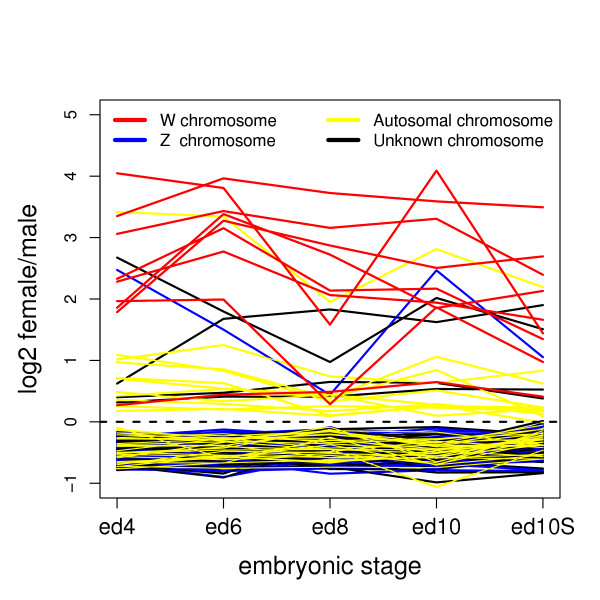
Expression difference between females and males of W-linked (red), Z-linked (blue), and autosomal (yellow) genes, and genes with unknown location (black), at ed4, 6, 8 and 10, respectively, for the 146 clones identified as significantly differentially expressed (adjusted p-value < 0.0005) in the microarray analysis. The log2 female/male ratios are averages between four replicate microarrays, using either the design illustrated in Figure 1A (ed4, ed6, ed8 and ed10), based on pools, or the design in Figure 1B (ed10S), based on separate individuals.